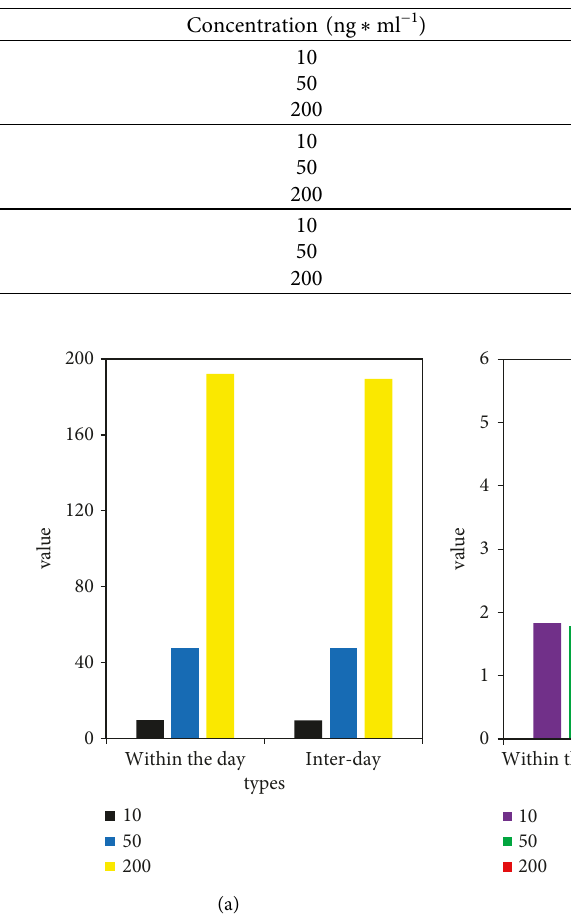
Table 3: Investigation of brain tissue matrix effect.